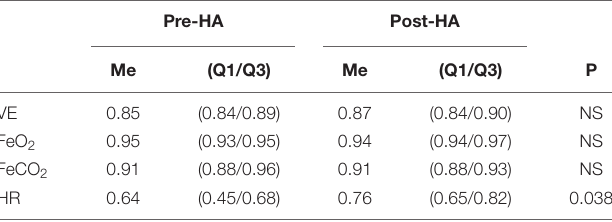
TABLE 3 | Projection of the cardiorespiratory variables onto PC1 pre- and post-HA (entire measurement).